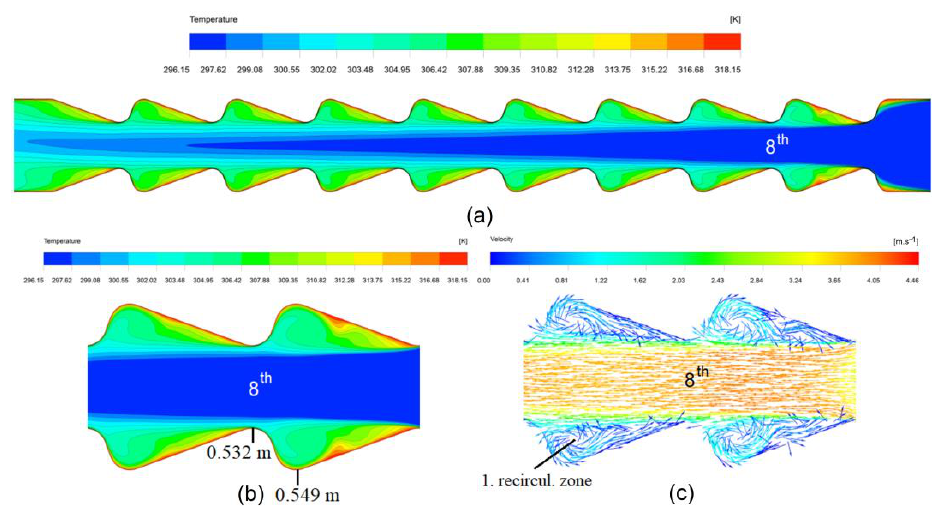
Figure 6. The temperature fields and velocity vectors of the WCA configuration ( Q = 50 m 3 /h), ( a ) temperature fields along the channel, ( b ) detail of the 2nd protrusion — temperature fields, ( c ) detail of the 2nd protrusion — velocity vectors.